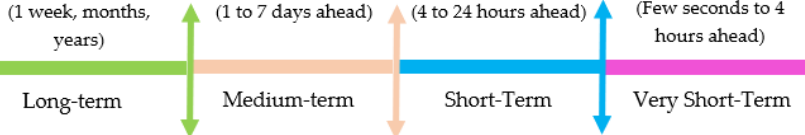
Figure 6. Classification of forecasting models according to their time horizon.